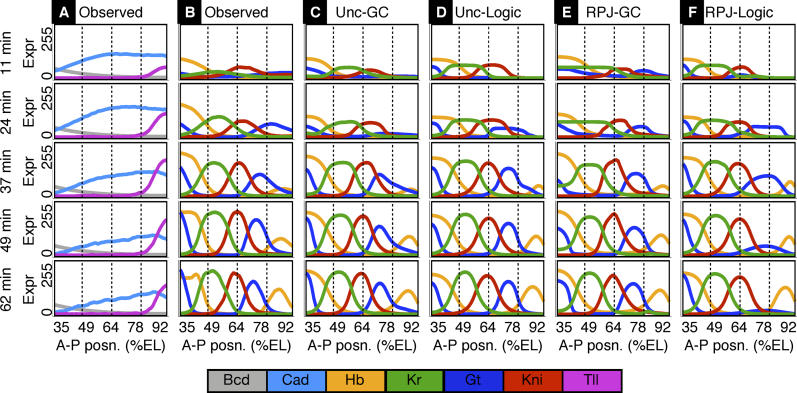
Observed and Simulated Expression at Five Time Points(A) Observed expression of bcd, cad, and tll, which are not modeled, but which are allowed to act as exogenous inputs to the trunk gap gene models.(B) Observed expression of the trunk gap genes.(C–F) Simulated expression produced by the models Unc-GC, Unc-Logic, RPJ-GC, and RPJ-Logic, respectively. The horizontal axis in each plot is A–P position, ranging from 35% to 92% of embryo length. The vertical axis represents relative protein concentration corresponding to fluorescence intensity from quantitative gene expression data [18] (units arbitrary).